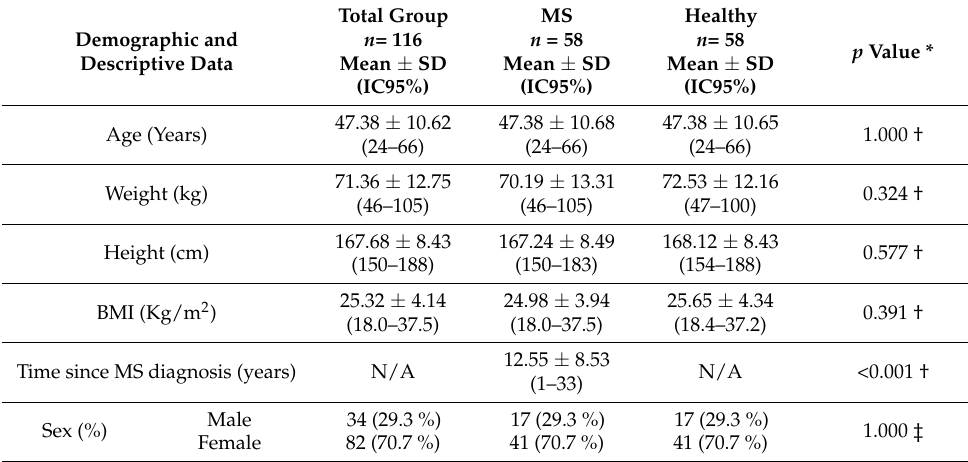
Table 1. Descriptive and socio-demographic data of the sample.